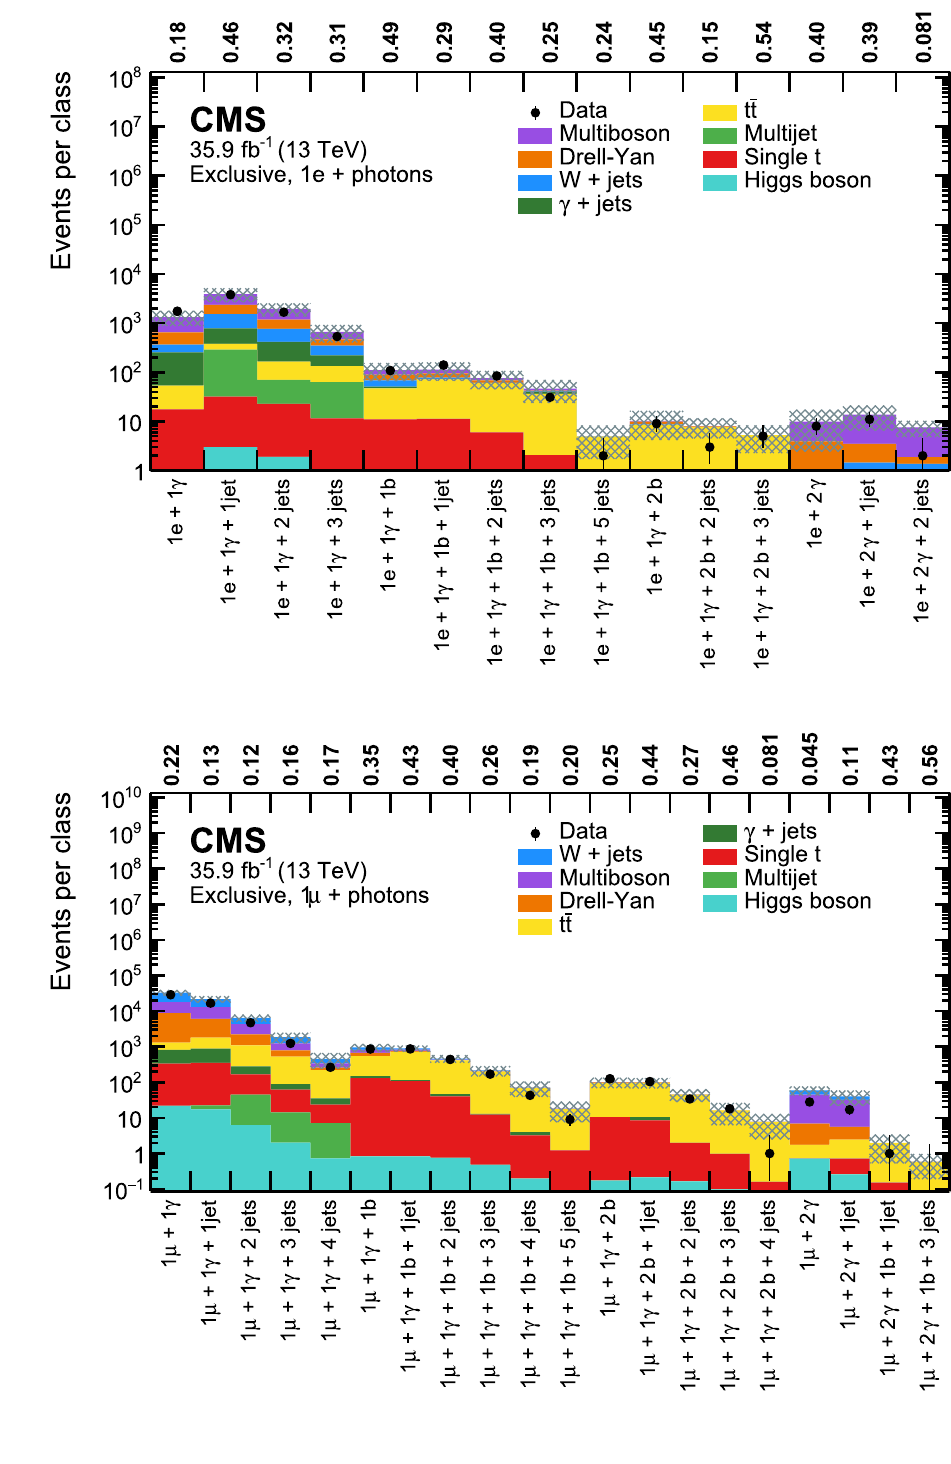
Fig. 17 Overview of total event yields for the event classes of the single-electron + photons (upper) and the single-muon + photons (lower) object groups. Measured data are shown as black markers, contributions from SM processes are represented by coloured histograms, and the shaded region represents the uncertainty in the SM background. The numbers above the plot indicate the observed p value for the agreement of data and